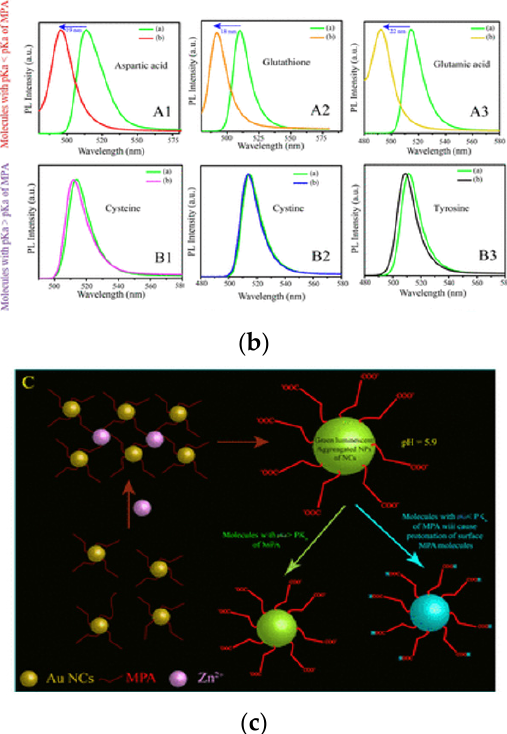
Figure 4. ( a ): Schematic illustration depicting possible mode of reaction among Au NCs-fluorescein composite and cysteine/glutathione. Reprinted with permission from [79]. Copyright 2018 American Chemical Society. ( b ) Variation in emission spectra of Zn Au NCs upon interaction with aspartic acid, glutathione, glutamic acid, cysteine, cystine and tyrosine. ( c ) Schematic illustration depicting possible mode of reaction among Zn Au NCs and aforementioned molecules. Reprinted with permission from [81] . Copyright 2019 American Chemical Society.